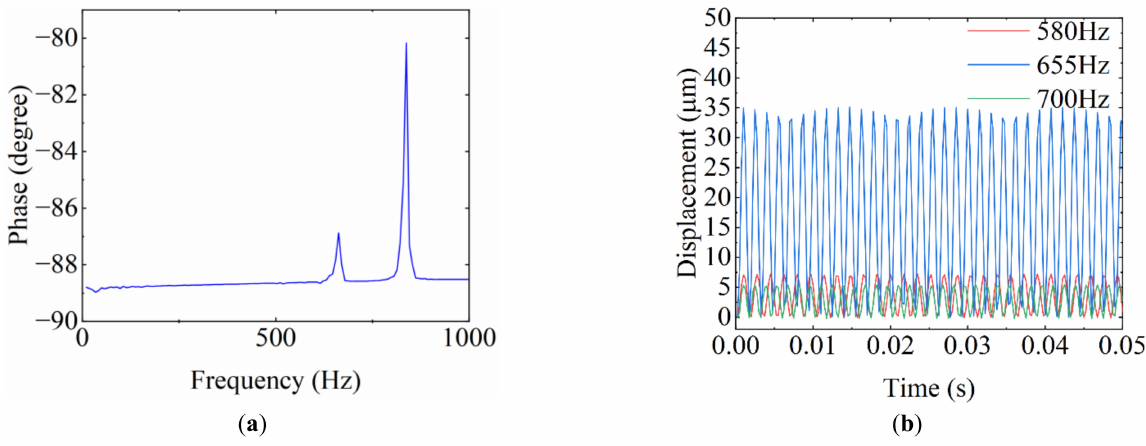
Figure 12. ( a ) Response frequency. ( b ) Amplitude test.